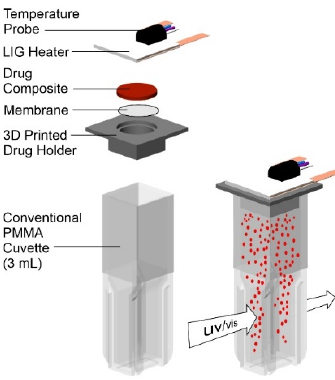
Figure 4. Spectroscopic cell configuration used to monitor the release of the model drug components as a consequence of heat applied from the LIG patch.